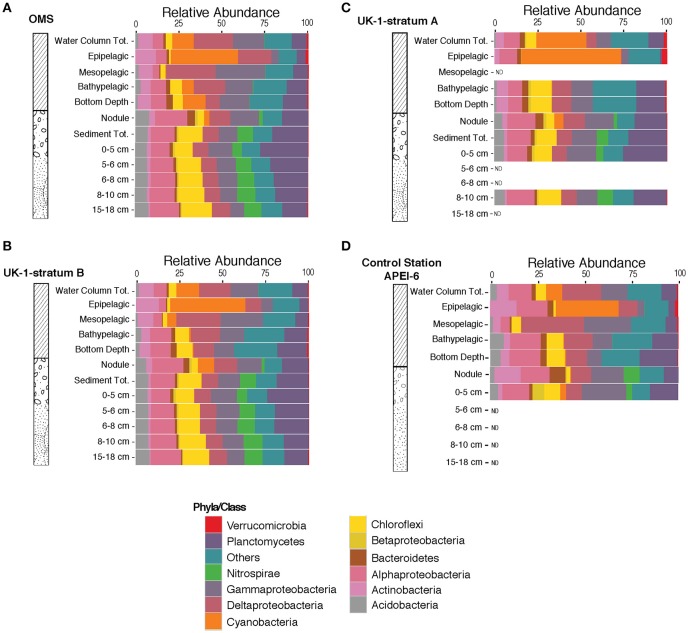
Relative abundances of operational taxonomic units binned at phyla/class level in the three different strata OMS Stratum A (A), UK-1 Stratum B (B), UK-1 Stratum A (C), and APEI-6 (D). Relative abundances were averaged over all samples collected in each stratum and different habitat (water column, sediment and nodules) and vertical segments within habitats (i.e., the epipelagic, mesopelagic, and bathypelagic zones, the 0–5, 5–6, 6–8, 8–10, and 15–18 cm sediment layers and nodules).